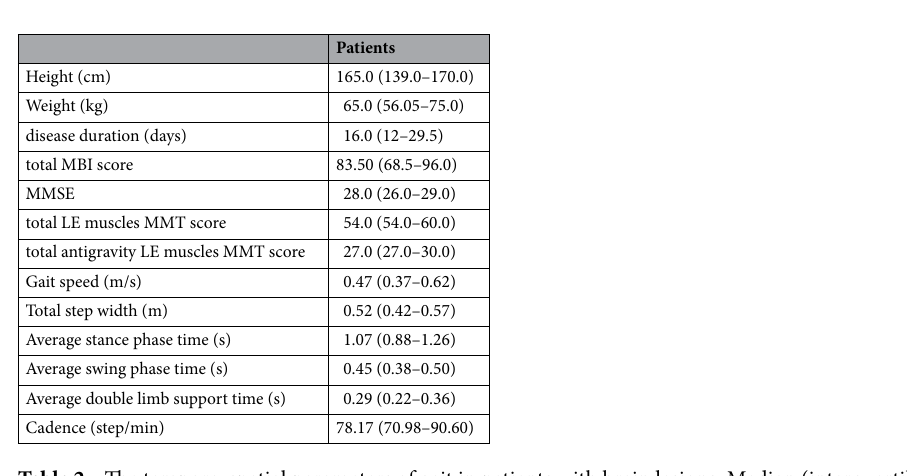
Table 2. The temporo-spatial parameters of gait in patients with brain lesions. Median (interquartile range), MBI modified Barthel’s index, MMSE mini mental status examination, LE lower extremity, MMT manual muscle